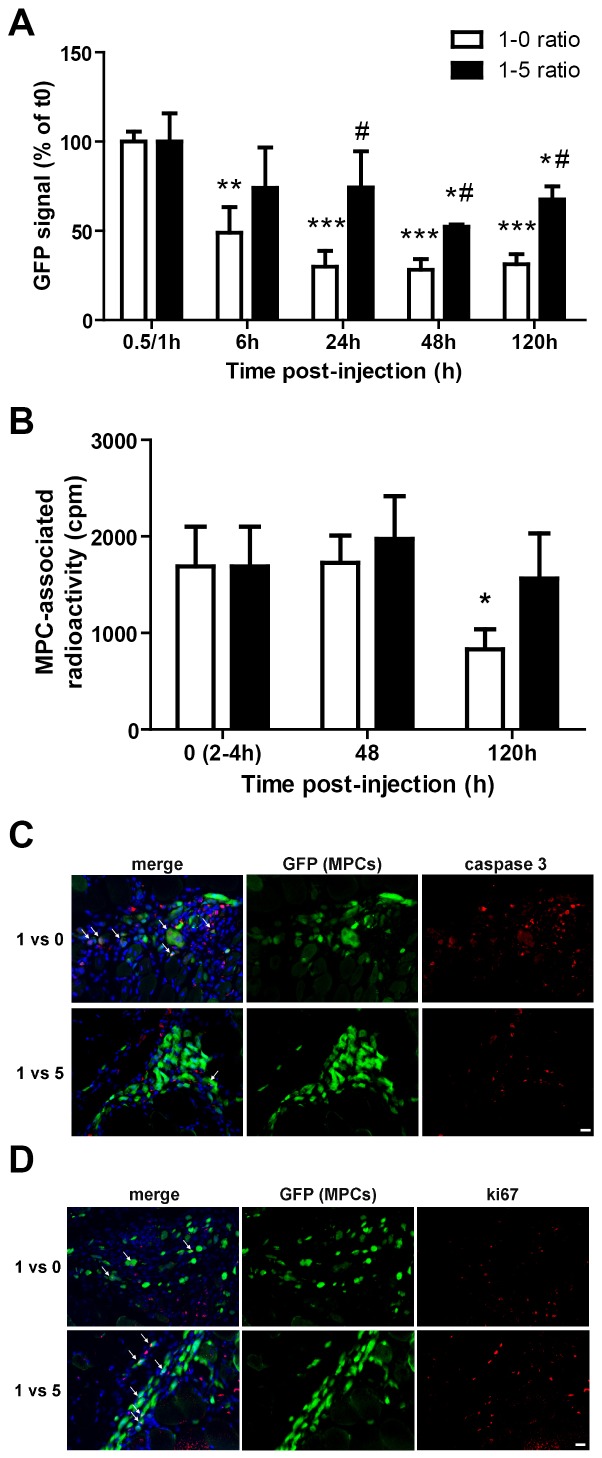
Effects of MPs on MPC engraftment in skeletal muscle.(A) GFP-MPCs were injected in mdx TA muscle with or without MPs at 1∶0 and 1∶5 ratios. At different time points after transplantation, the amount of GFP contained in injected muscles was evaluated by immunoblotting and expressed in % of the signal evaluated at time 0.5/1 h (results represent mean ± sem of 3 independent experiments). *: versus time 0.5/1 h (** = P<0.01, *** = P<0.001). #: 1∶5 versus 1∶0 ratio at each time point (# = P<0.05). (B) Radiolabelled MPCs were injected in mdx TA muscle with or without MPs at 1∶5 ratio. At 0 (2/4 h), 2 and 5 days after transplantation, radioactivity contained in injected muscles was measured and expressed in cpm (results represent mean ± sem of 4 independent experiments). *: versus d0(2/4 h) P<0.05. (C) Sections of muscles injected with GFP-MPCs with or without MPs were labelled for caspase 3. Arrows show double stained apoptotic MPCs. Bar = 10 µm. (D) Sections of muscles injected with GFP-MPCs with or without MPs were labelled for ki67. Arrows show double stained cycling MPCs. Bar = 10 µm.